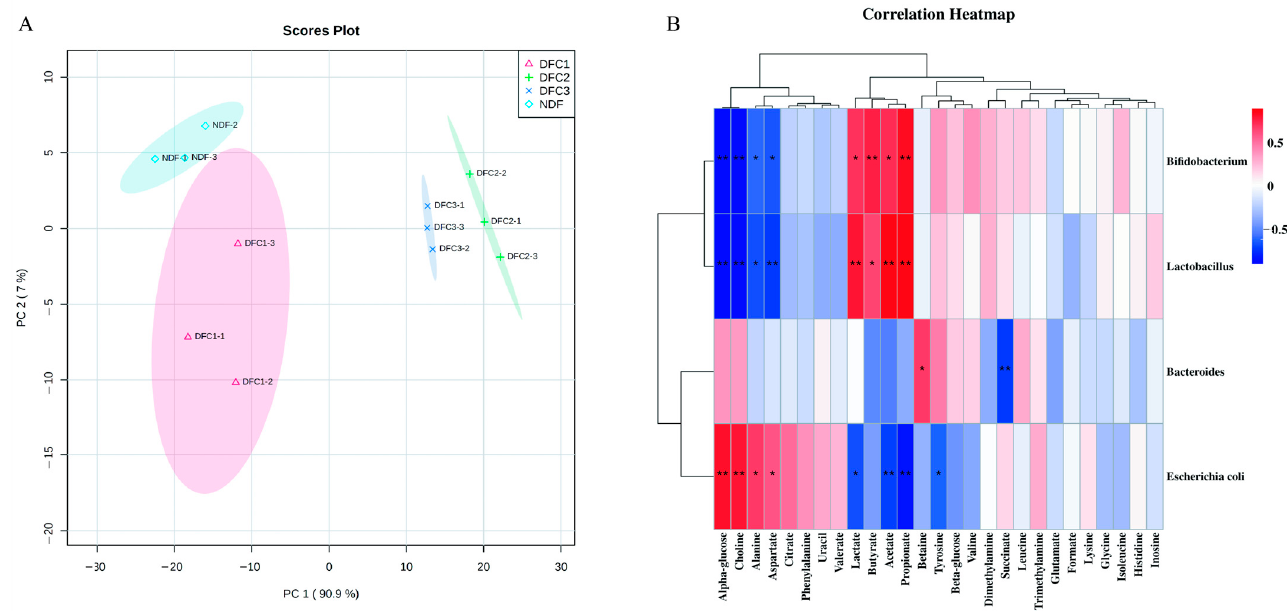
Figure 4. ( A ) Scatter plot of PCA scores ( B ) Heat map of correlation between metabolites and characteristic human flora of different DFCs and NDF. Note: *, p < 0.05; **, p <